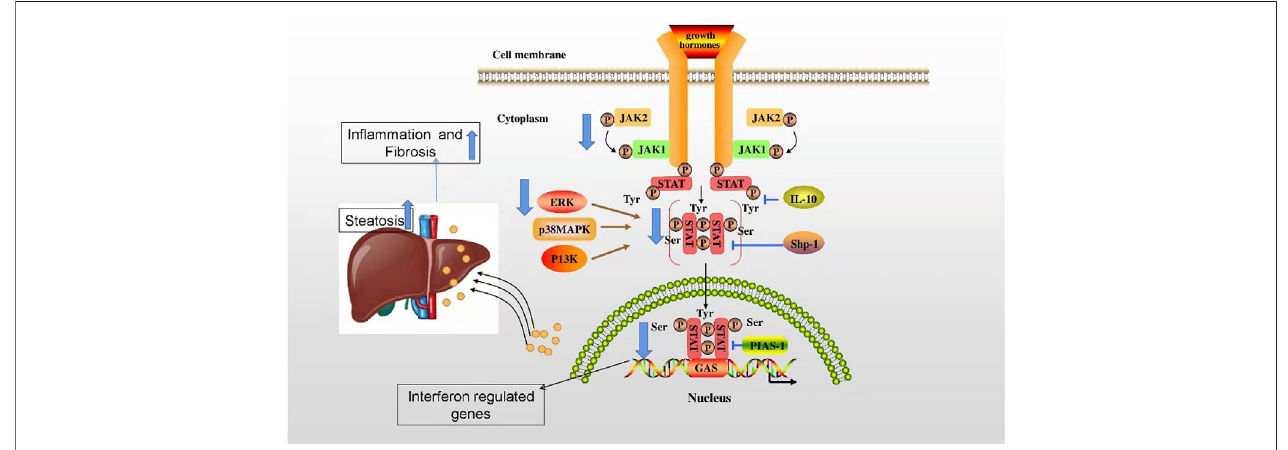
FIGURE 3 | The regulatory mechanism of lamin in alleviation of MAFLD. The de fi ciency of lamin A/C upregulates stat1 mRNA and protein levels and blocks JAK2, Stat 5, and ERK mediated by the liver GH receptor signal, thus downregulating the expression of stat5-dependent male-speci fi c genes, ultimately promoting excessive fatty acids, in fl ammation, and fi brosis in hepatocytes and exacerbating the progression of